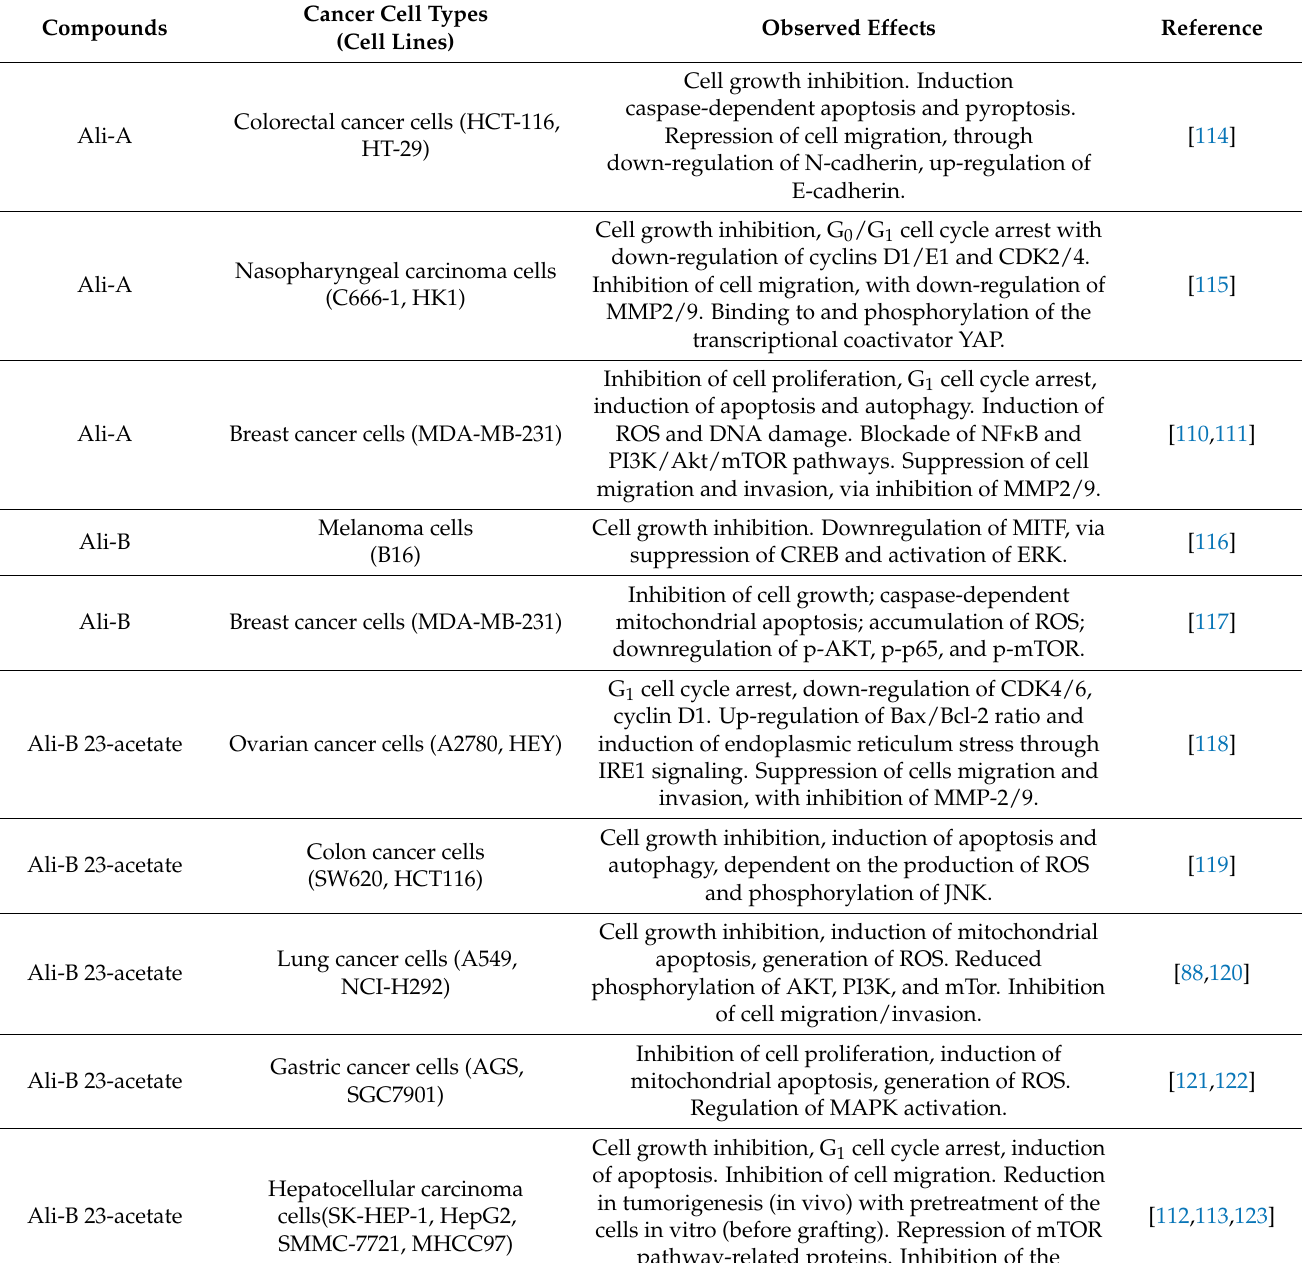
Table 1. Anticancer activity of alisol